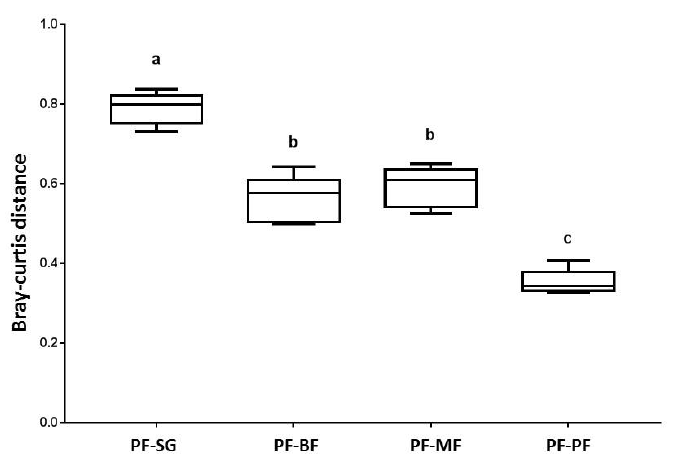
Figure 3. Bray–Curtis distance of bacterial communities at the operational taxonomic unit (OTU) level between rehabilitation age and primary forest communities. SG: Shrub-grassland; BF: Broad leaved; MF: Coniferous broad-leaved; PF: Primary